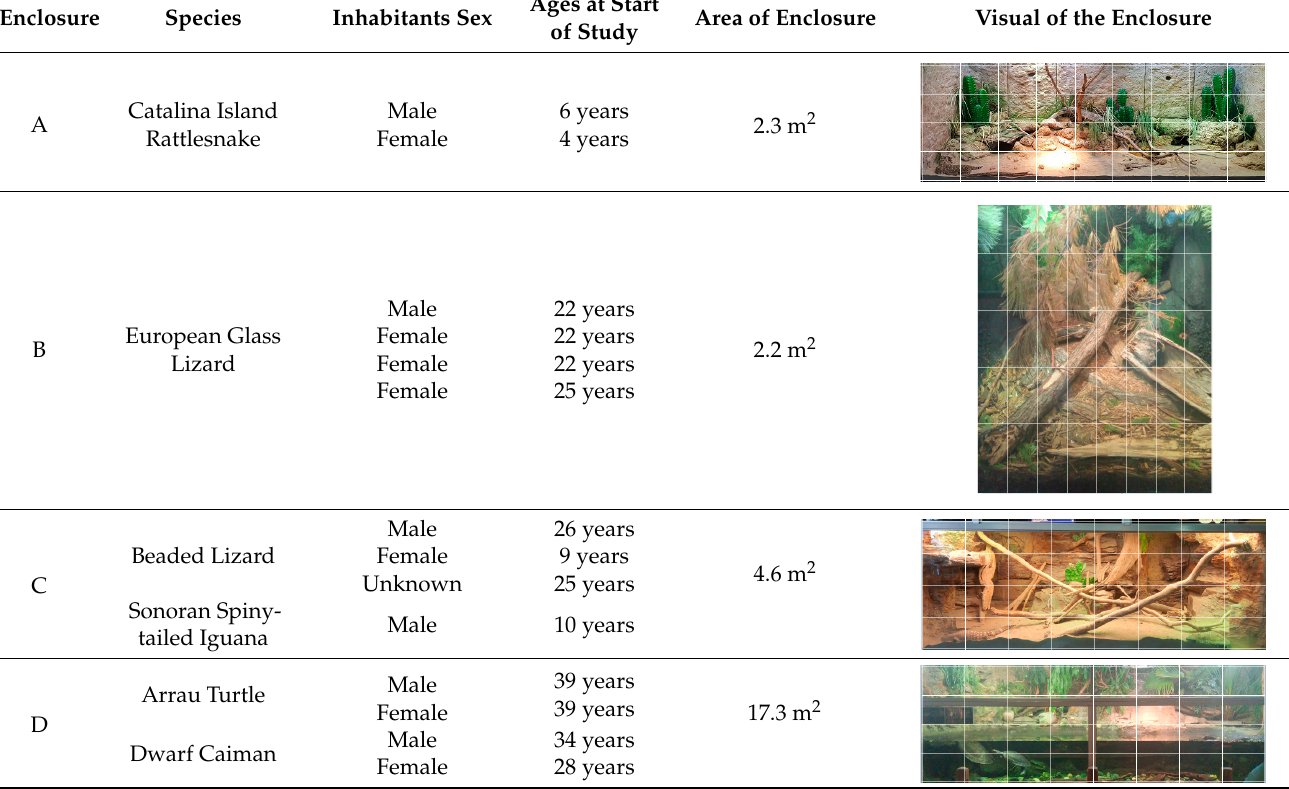
Table 2. Summary of enclosure, species, and individual information.